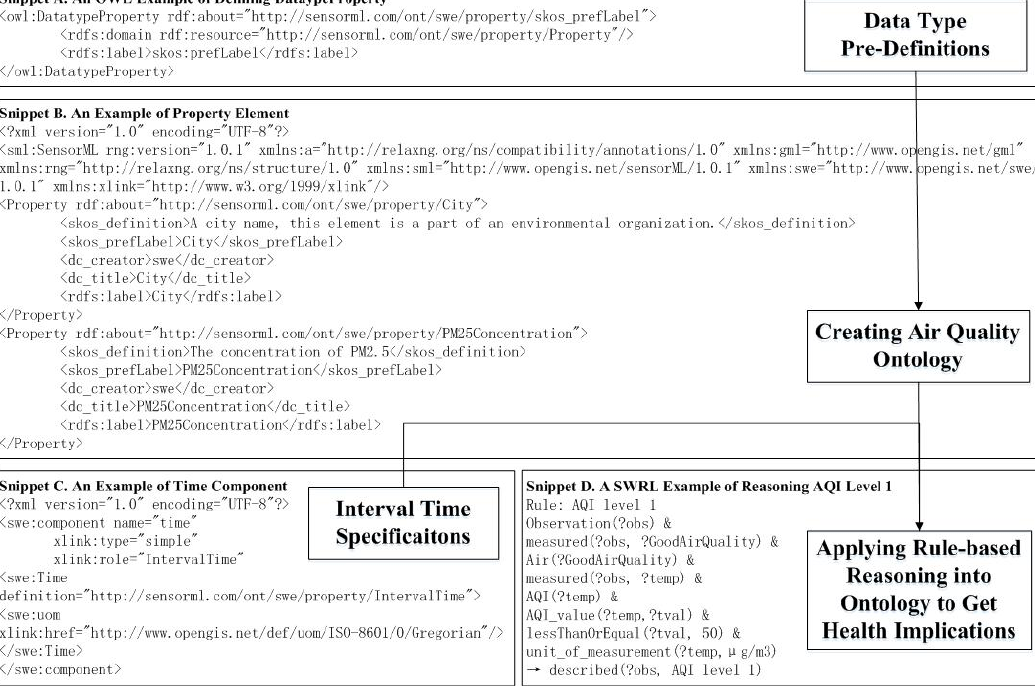
Figure 10. Processing an air quality and health implications querying Instance.